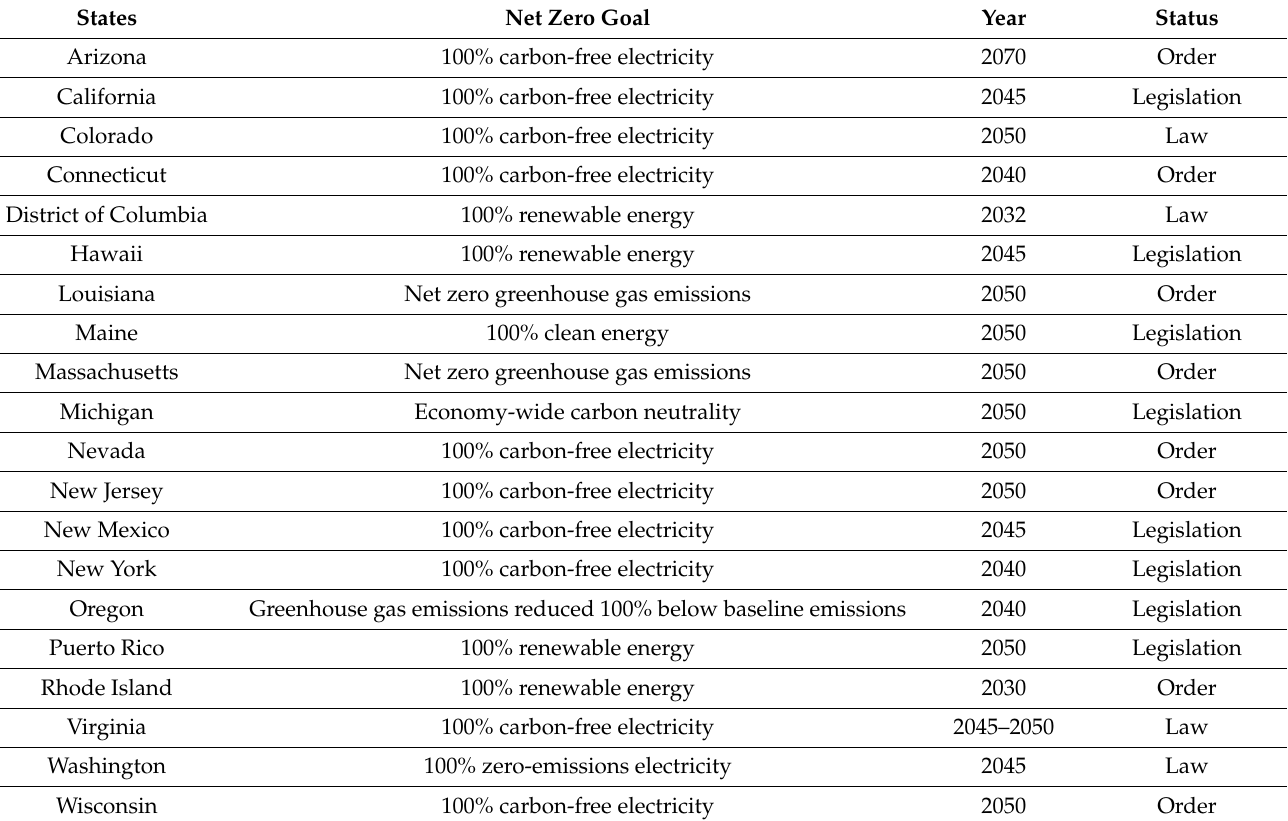
Table 1. States with net zero targets. Source: modified from the Clean Energy States Alliance [13].